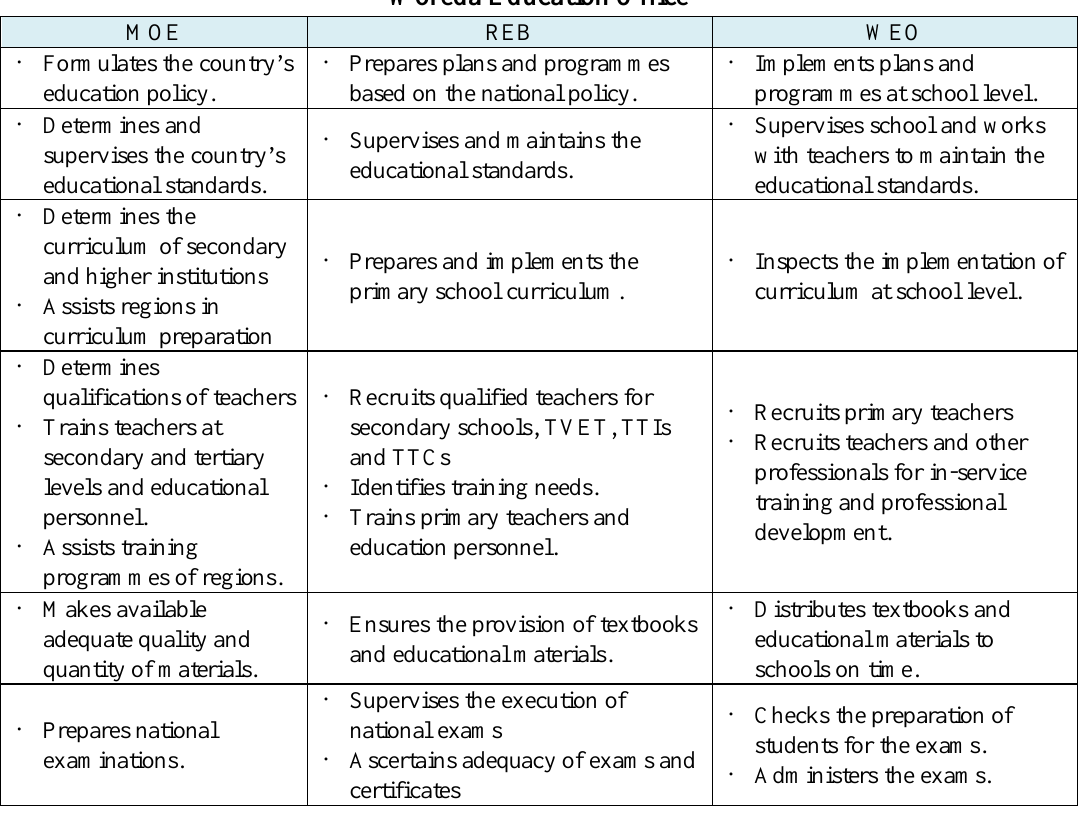
Table 5-1: Responsibilities of the Ministry of Education, Regional Education Bureau